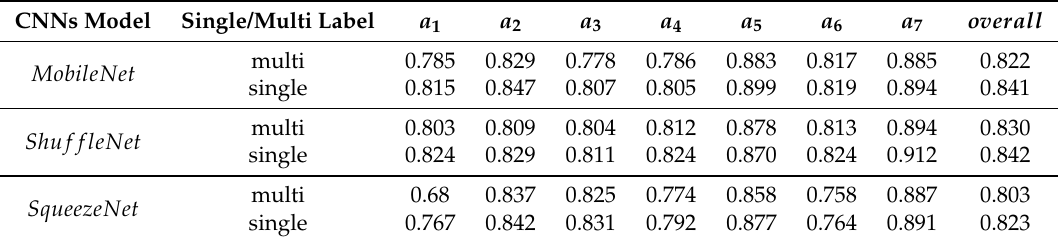
Table 4. Single label model vs. multi-label model.